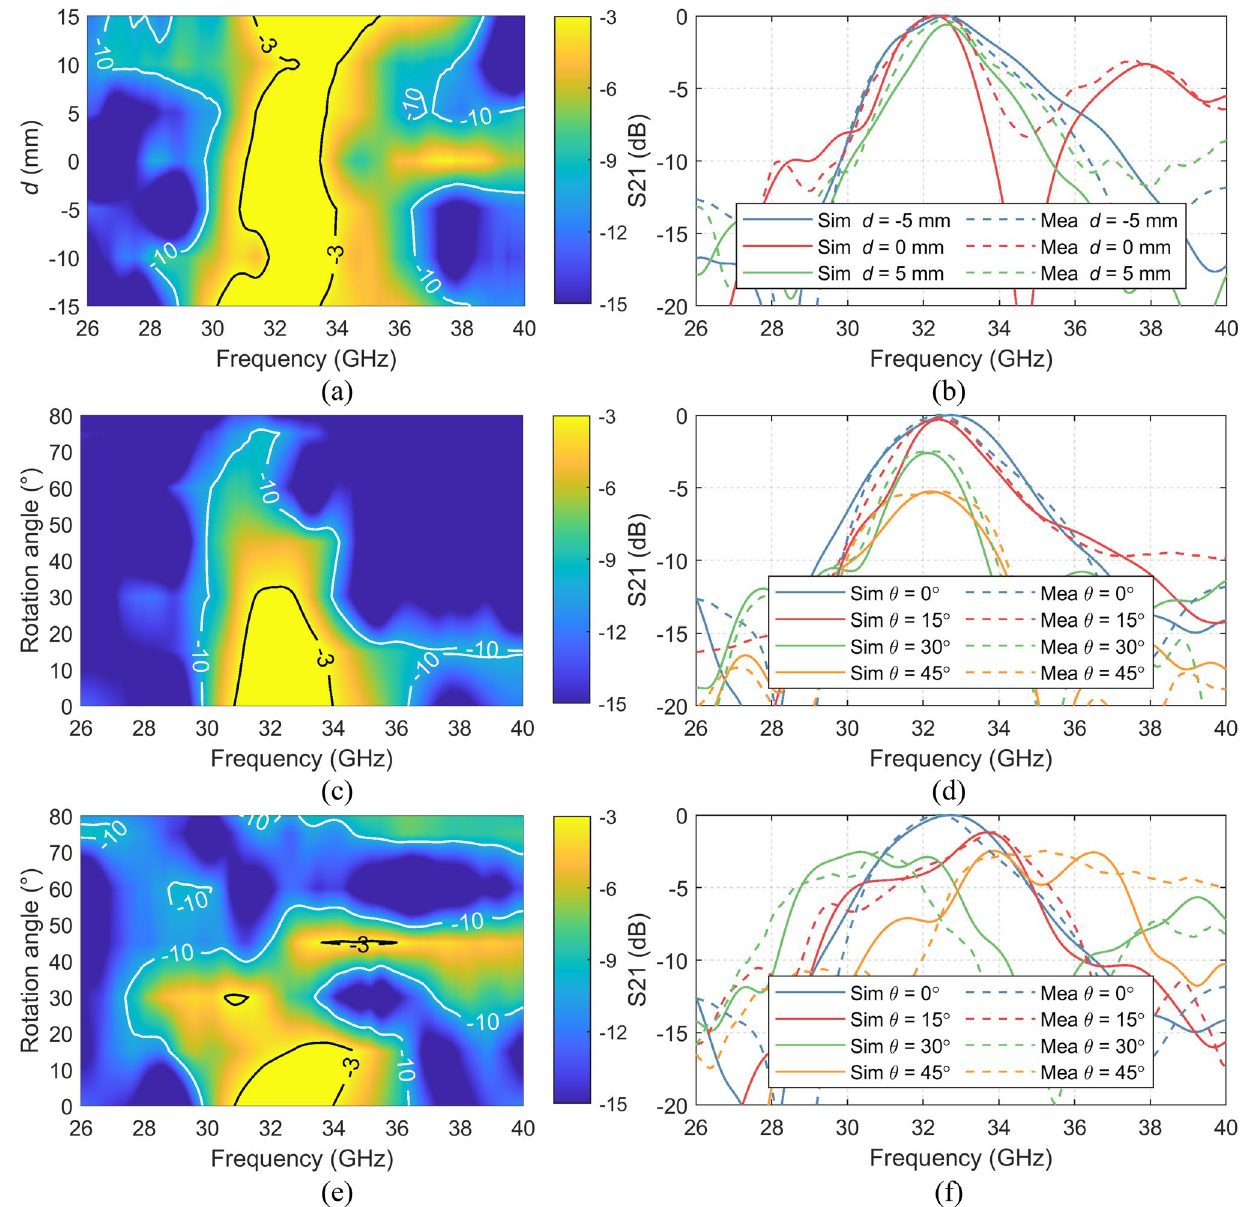
Figure. 10. (a) Colormap of measured S21 of the conformal FSS as a function of the distance between the FSS and the receiver; (b) comparison between selective simulated and measured S21 results as a function of the distance; (c) colormap of measured S21 of the conformal FSS as a function of the angle in TE incidence; (d) comparison between selective simulated and measured S21 results as a function of the angle in TE incidence; (e) colormap of measured S21 of the conformal FSS as a function of the angle in TM incidence; (f) comparison between selective simulated and measured S21 results as a function of the angle in TM